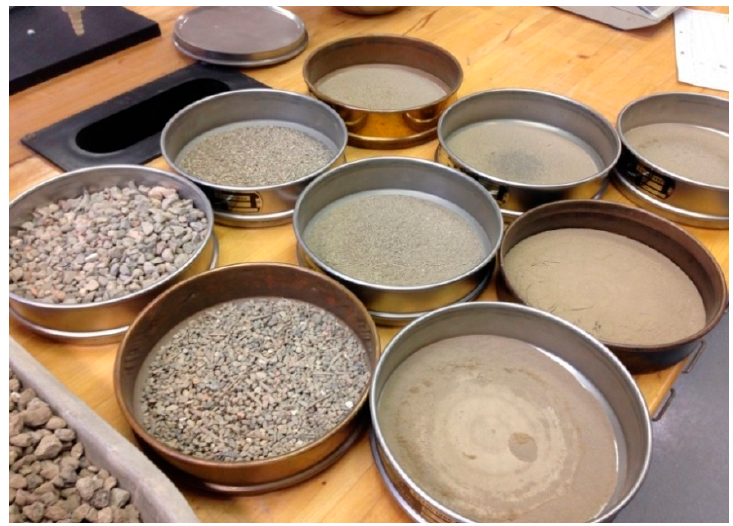
Figure 2. Aggregate Gradation by Particle Size Distribution Test.